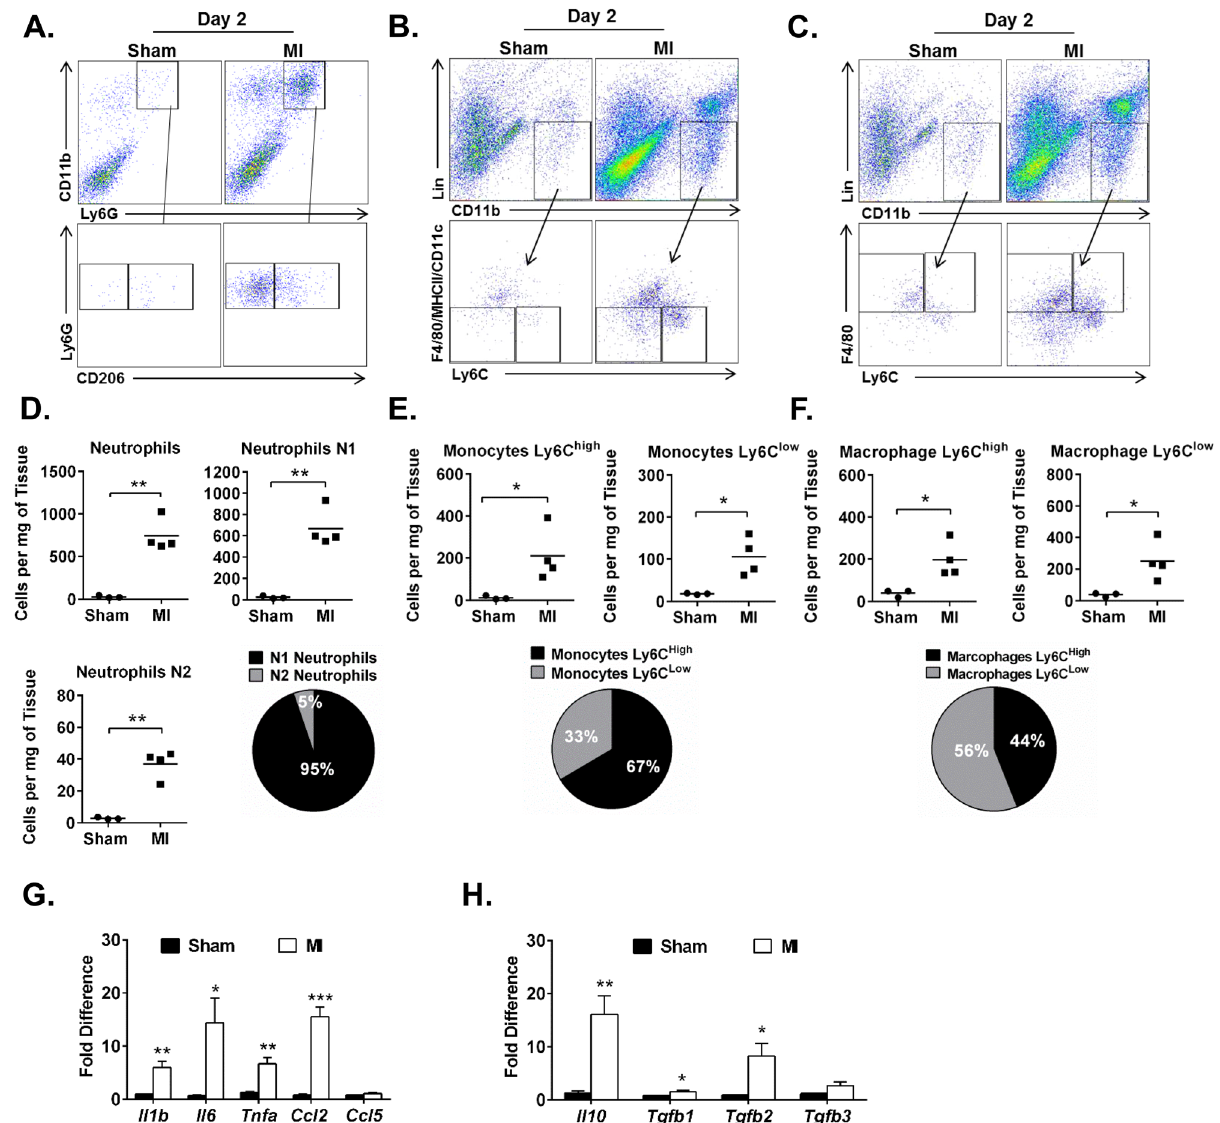
Figure 1. Mouse hearts 2 d after MI are infiltrated in pro-inflammatory immune cells. Cell suspensions of enzymatically digested hearts from sham and MI mice were stained with fluorescently labeled antibodies. Representative dot plots identified: ( A ) neutrophils as CD11b pos Ly6G pos cells, which were stratified into N1 (CD206 neg ) and N2 (CD206 pos ) subpopulations; ( B ) monocytes Lin neg CD11b pos (F4/80/CD11c/MHCII) low with Ly6C high and Ly6C low expression; ( C ) macrophages Lin neg CD11b pos F4/80 high with Ly6C high and Ly6C low expression. Numerical representations of neutrophils ( D ), monocytes ( E ), and macrophages ( F ) and their subpopulations per mg of tissue; pie chart represents contribution of pro-inflammatory and anti-inflammatory cell subpopulations. Number of cells shown as mean; sham n = 3, MI n = 4; * P < 0.05; ** P < 0.01 ( unpaired t test ). Quantitative PCR on mRNA isolated from hearts 2 d after sham and MI. Messenger RNA expression of pro- inflammatory ( G ) and anti-inflammatory ( H ) cytokines and chemokines in whole hearts 2 d after sham and MI. Data are means ± SEM; sham n = 4, MI = 4; * P < 0.05; ** P < 0.01; *** P < 0.001 (unpaired t test